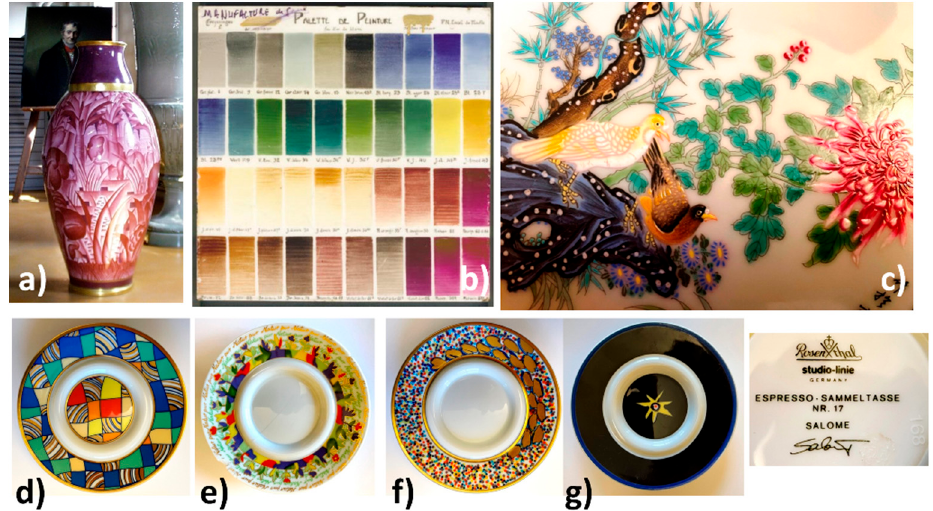
Figure 3. Selection of 20th century objects representative of the variety of colored decorations ob- tained with enamel on porcelain: ( a ) vase ‘ Inde ’ designed by F. Aubert and J. Beaumont for the ‘La